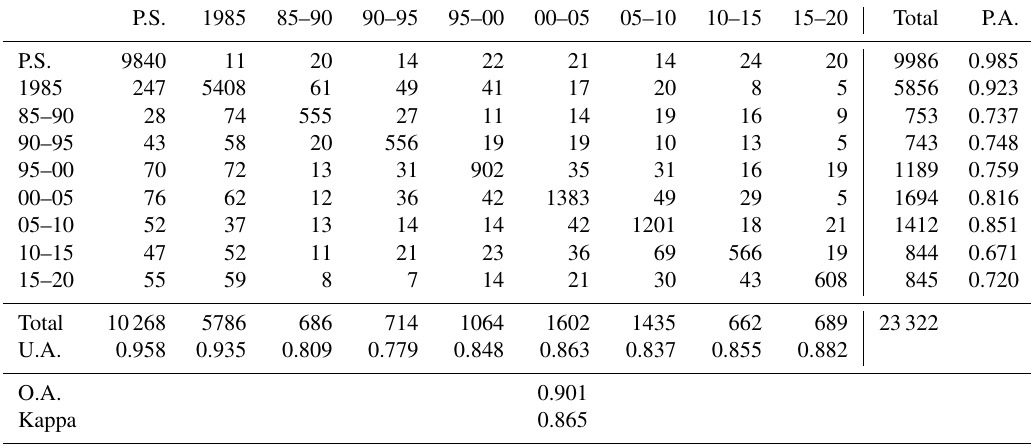
Table 1. The confusion matrix of our global 30m impervious-surface dynamic products using 23322 validation samples. P.S.